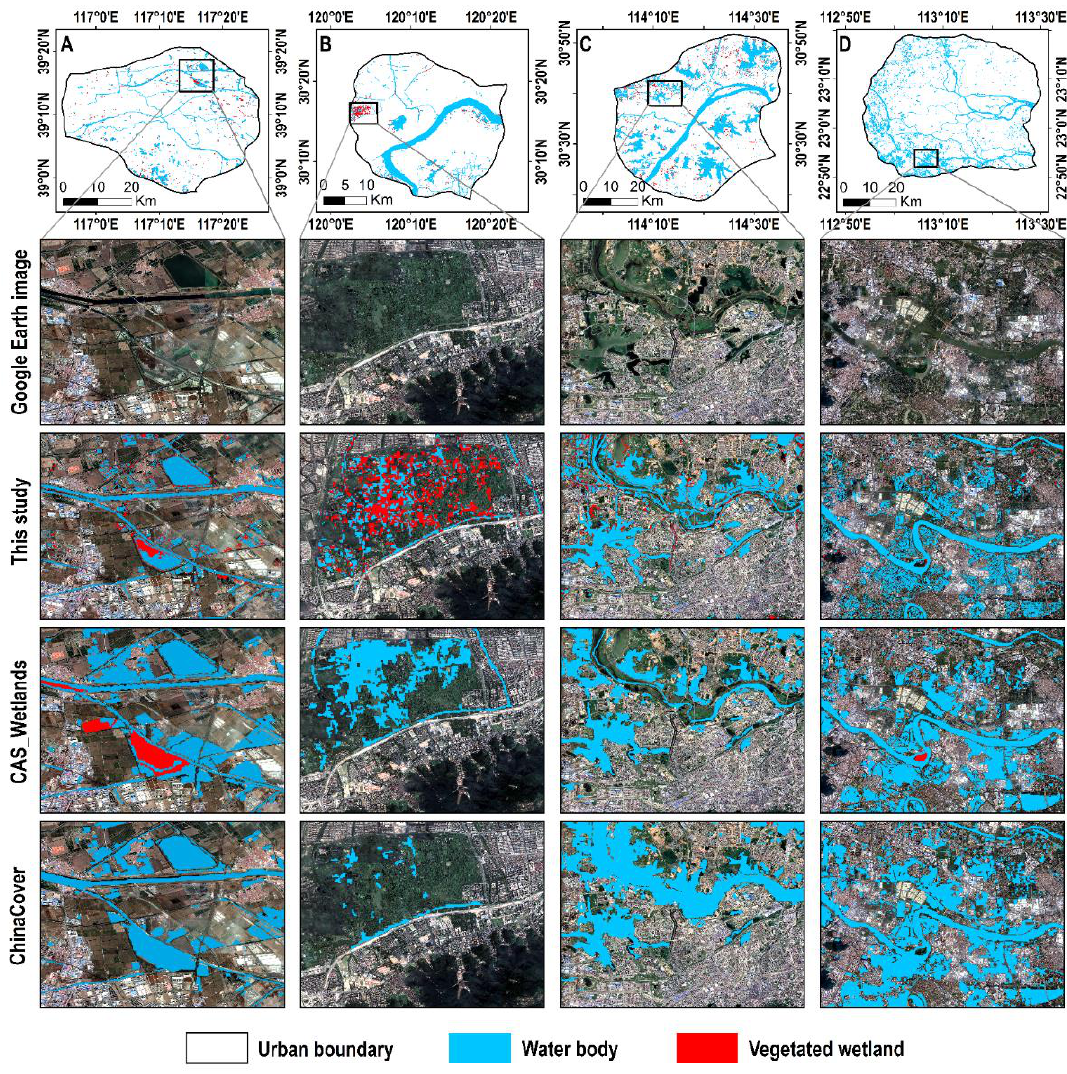
Figure 12. Urban wetland comparison between urban wetland map in 2015 of this study and other reported datasets including CAS_Wetlands and ChinaCover dataset. ( A–D ) present the urban wetlands of 2015 in four study sites (Site(A–D)), respectively. The subsets (rectangle scope) are the typical region of four study sites respectively to show the detail of urban wetland results. The backgrounds of the subset views are the latest Google Earth